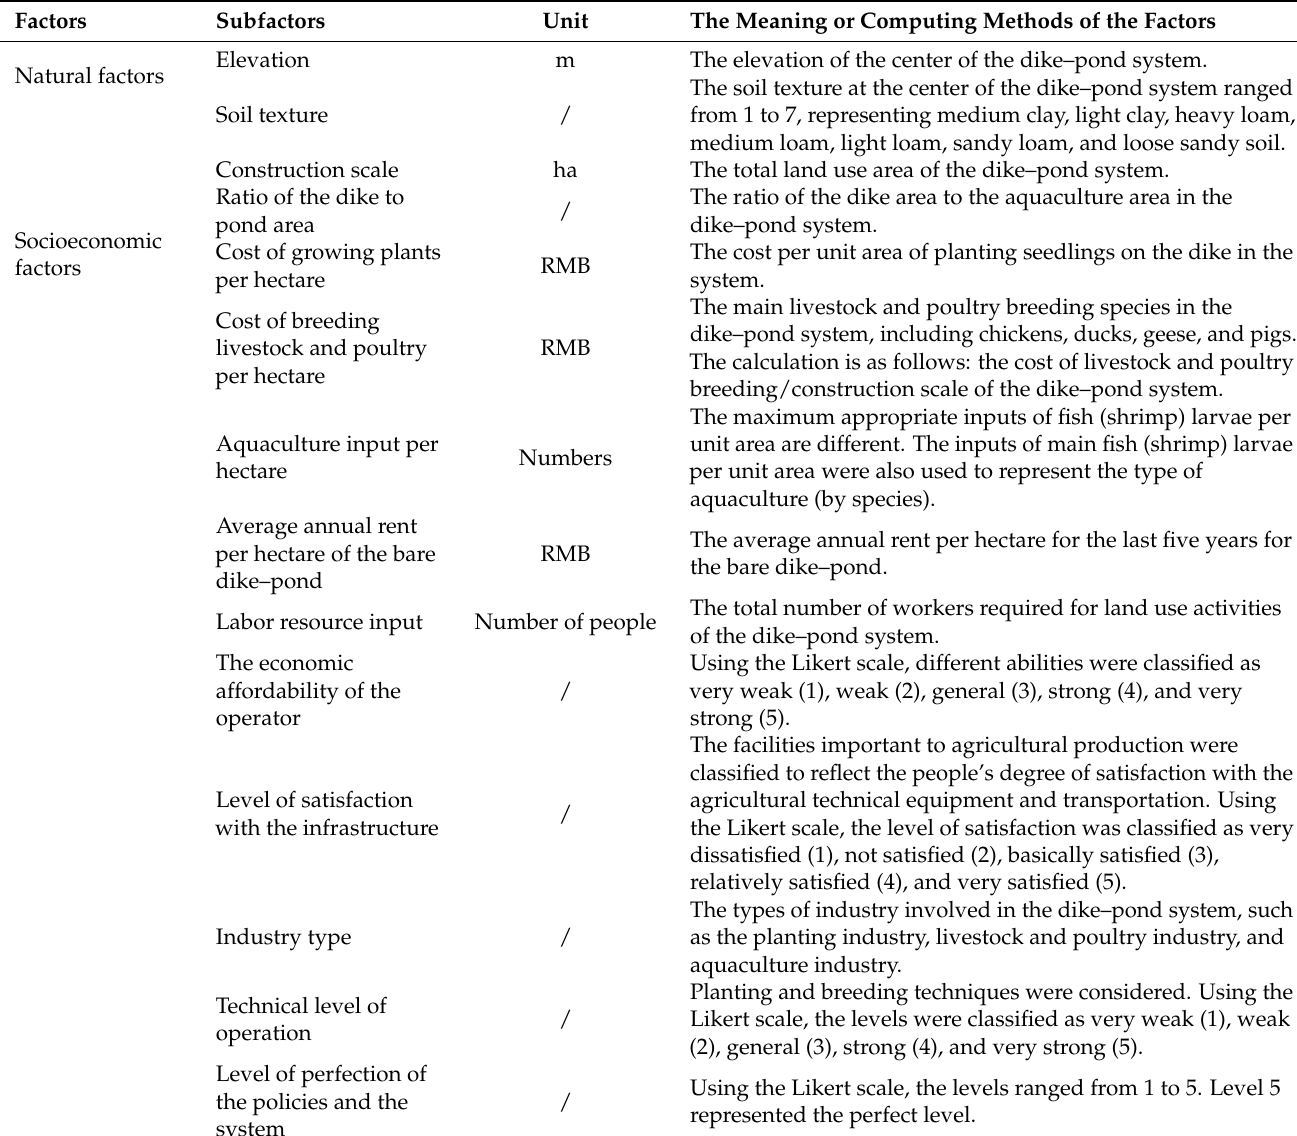
Table A1. Impact factors of land-use modes of the dike–pond